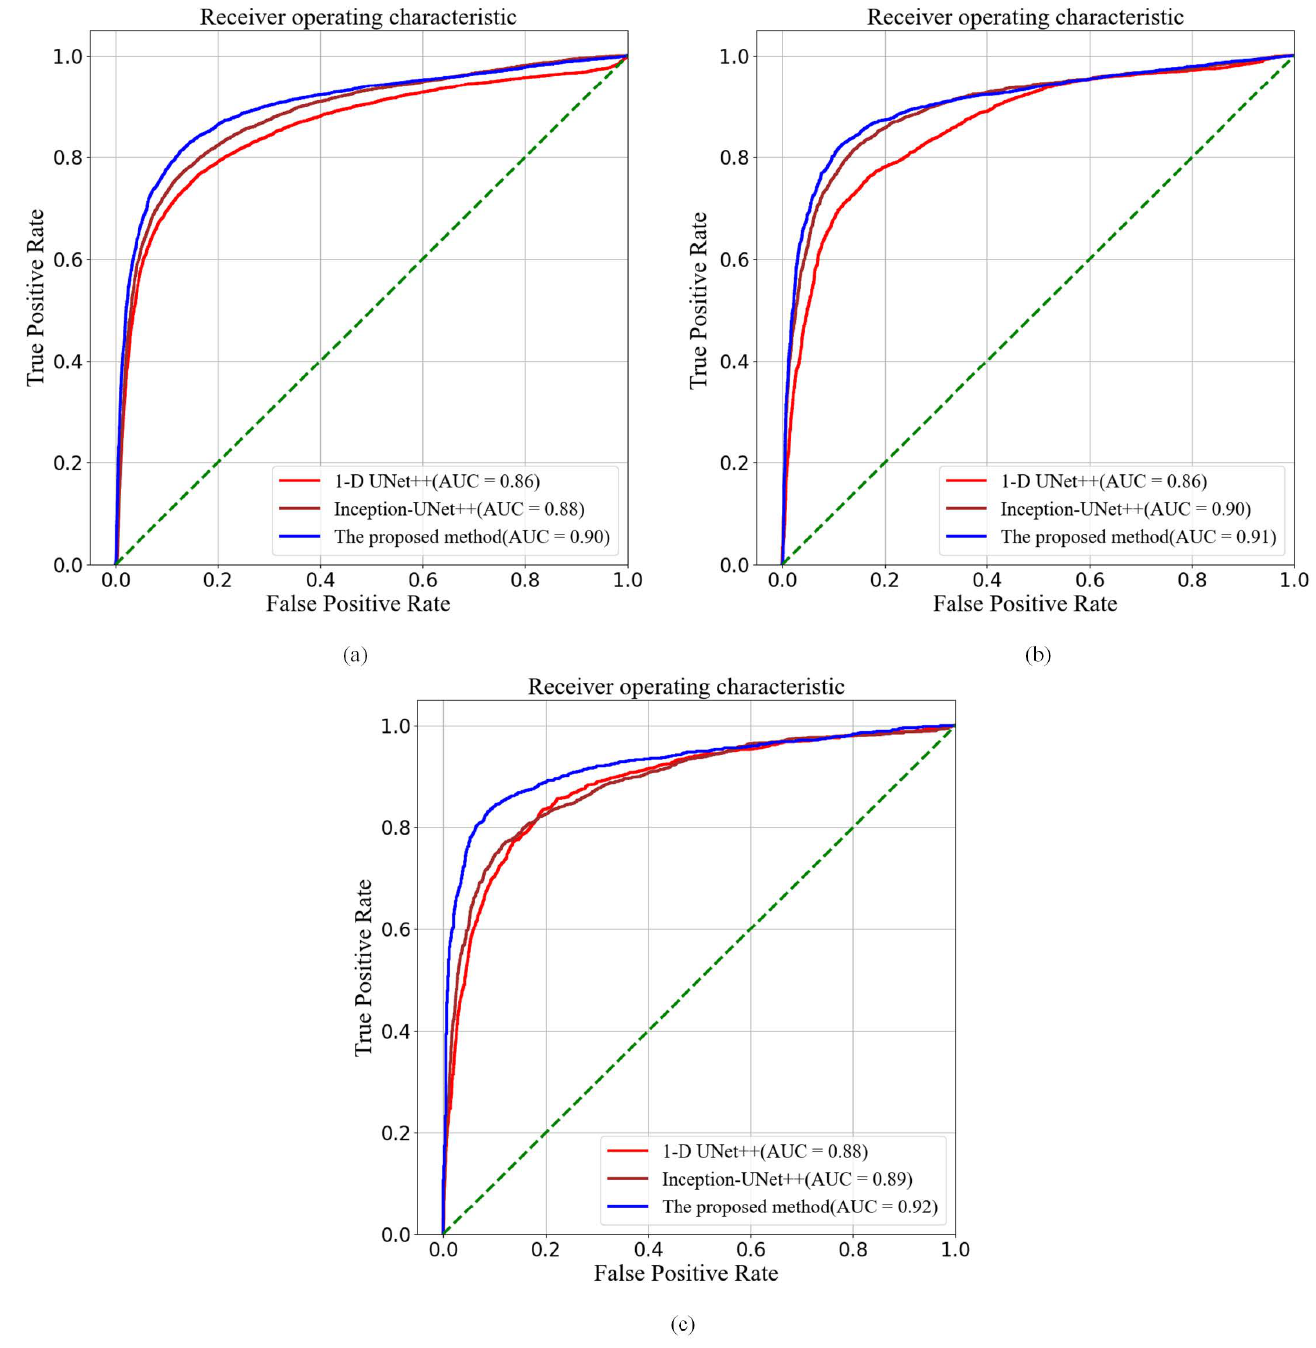
Figure 5. The ROC curve of CHF detection. ( a ) The RR segment length N = 500; ( b )The RR segment length N = 1000; ( c ) The RR segment length N = 2000.